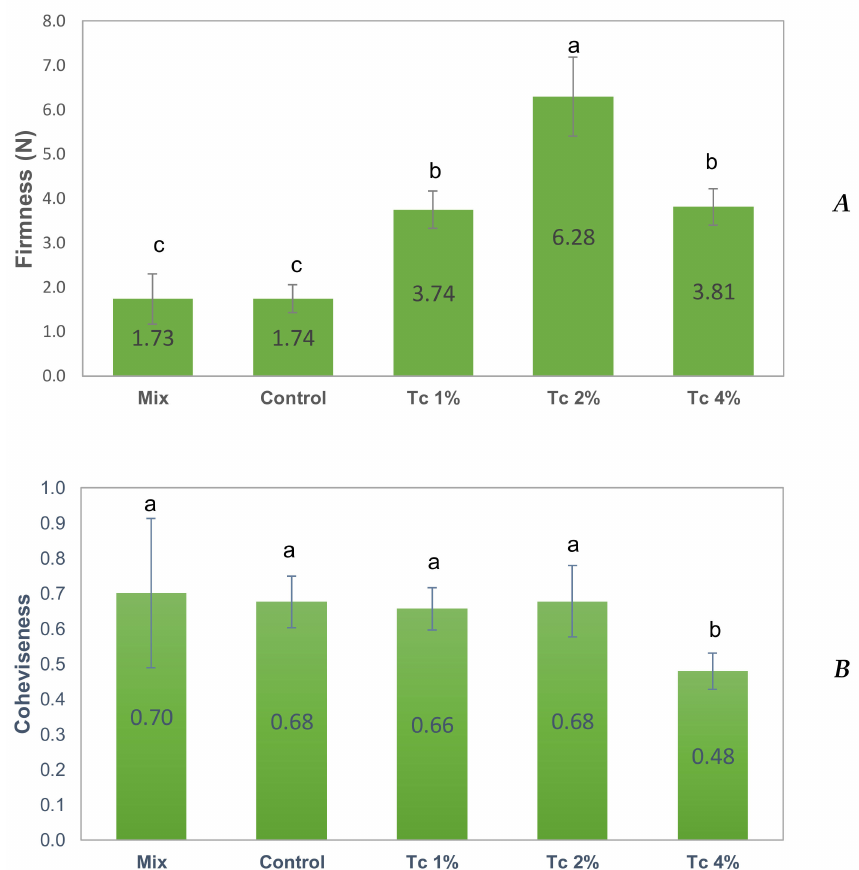
Figure 4. Firmness ( A ) and cohesiveness ( B ) values of GF doughs with T. chuii obtained by the